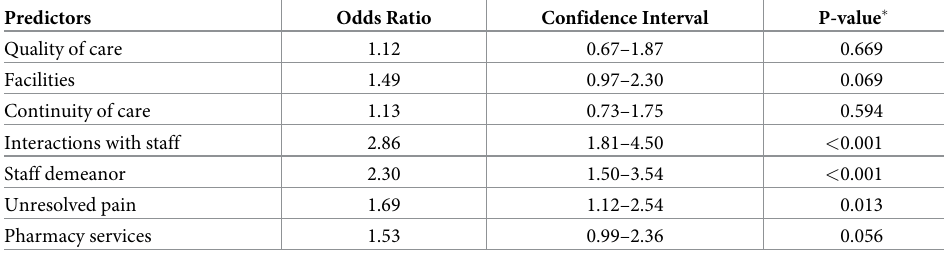
Table 4. Final multivariable model containing domains of dissatisfaction associated with any (vs. no) racial/eth- nic-based perceived discrimination while seeking healthcare (n = 622).